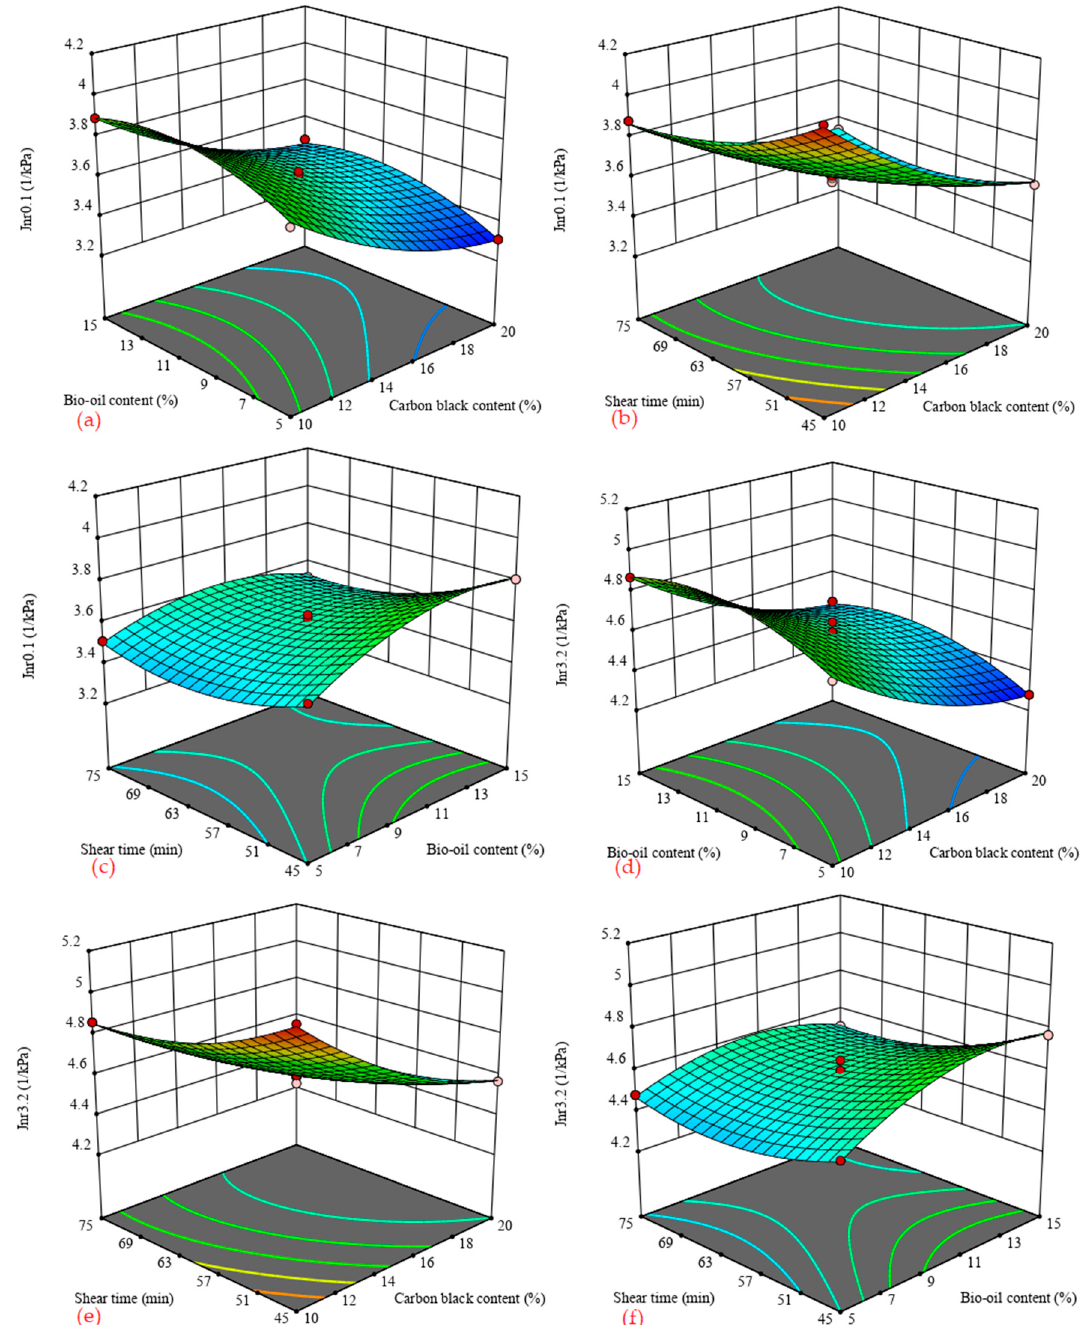
Figure 4. 3D surface of J nr value with influence factors. ( a ) shear time = 60 min; ( b ) bio-oil content = 10%; ( c ) carbon black content = 15%; ( d ) shear time = 60 min; ( e ) bio-oil content = 10%; ( f ) carbon black content = 15%.